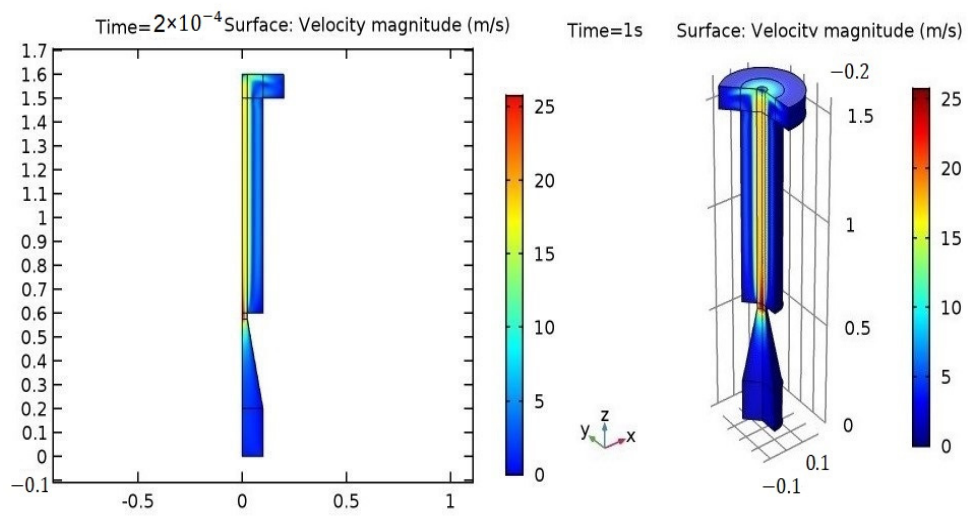
Figure 8. Effect of inlet velocity and shear rate on chitosan extrusion 3D printing.